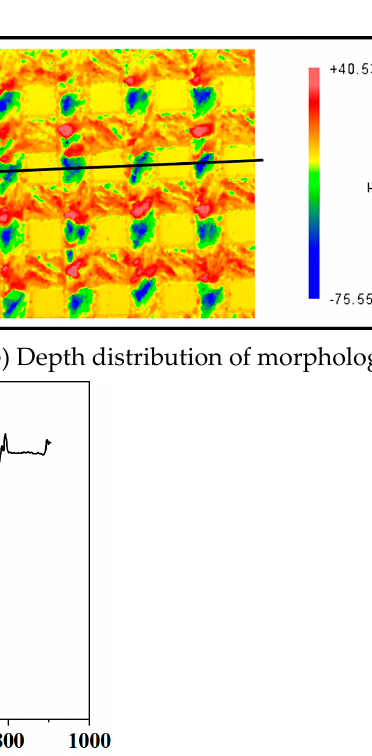
( d ) 15 pulse cycles Figure 3. Microstructure morphology and temperature fi eld distribution at di ff erent pulse cycles (Average power = 8 W, pulse width = 40 ns, frequency = 150 kHz, scanning speed = 100 mm/s). Figure 4a shows the experimental surface morphology of NdFeB with laser pro- cessing; the material was stacked at the edge of the columnar array structure. Figure 4c shows the change in section depth at the black line in Figure 4b. As can be seen from the fi gure, the processed groove has a large taper, and the average depth at the bo tt om is about 50 µm, while the depth of the simulation result is about 43 µm. In the simulation,